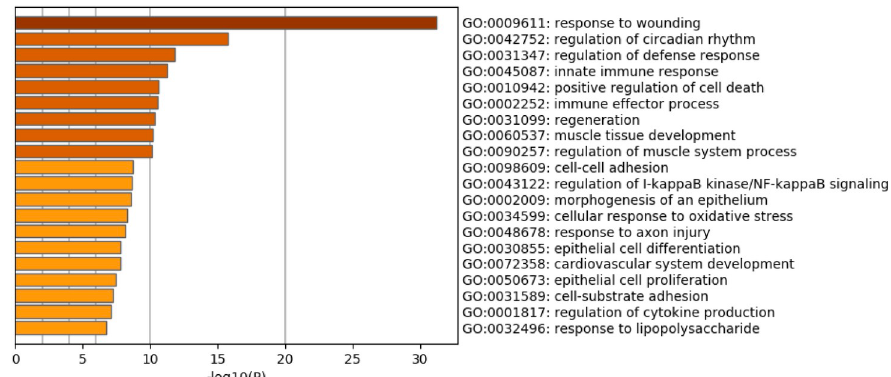
Fig 7. Enrichment results of the 212 DEG reflecting short-term effects. The figure presents the functional gene set enrichment analysis (GSEA) for the 212 selected DEG differentially-expressed between the ISO vs. na ï ve rats on Days 1 and 30. The X-axis is the negative log-transformed p-value of the enriched terms. The darker the color, the more statistically significant the enriched term (pathways, GO terms, etc.). Groups of rats exposed to air (na ï ve, n = 6/each timepoint group) or ISO (n = 5/Day 1 group, and n = 6/Day 30, 240, and 360 groups) were used.